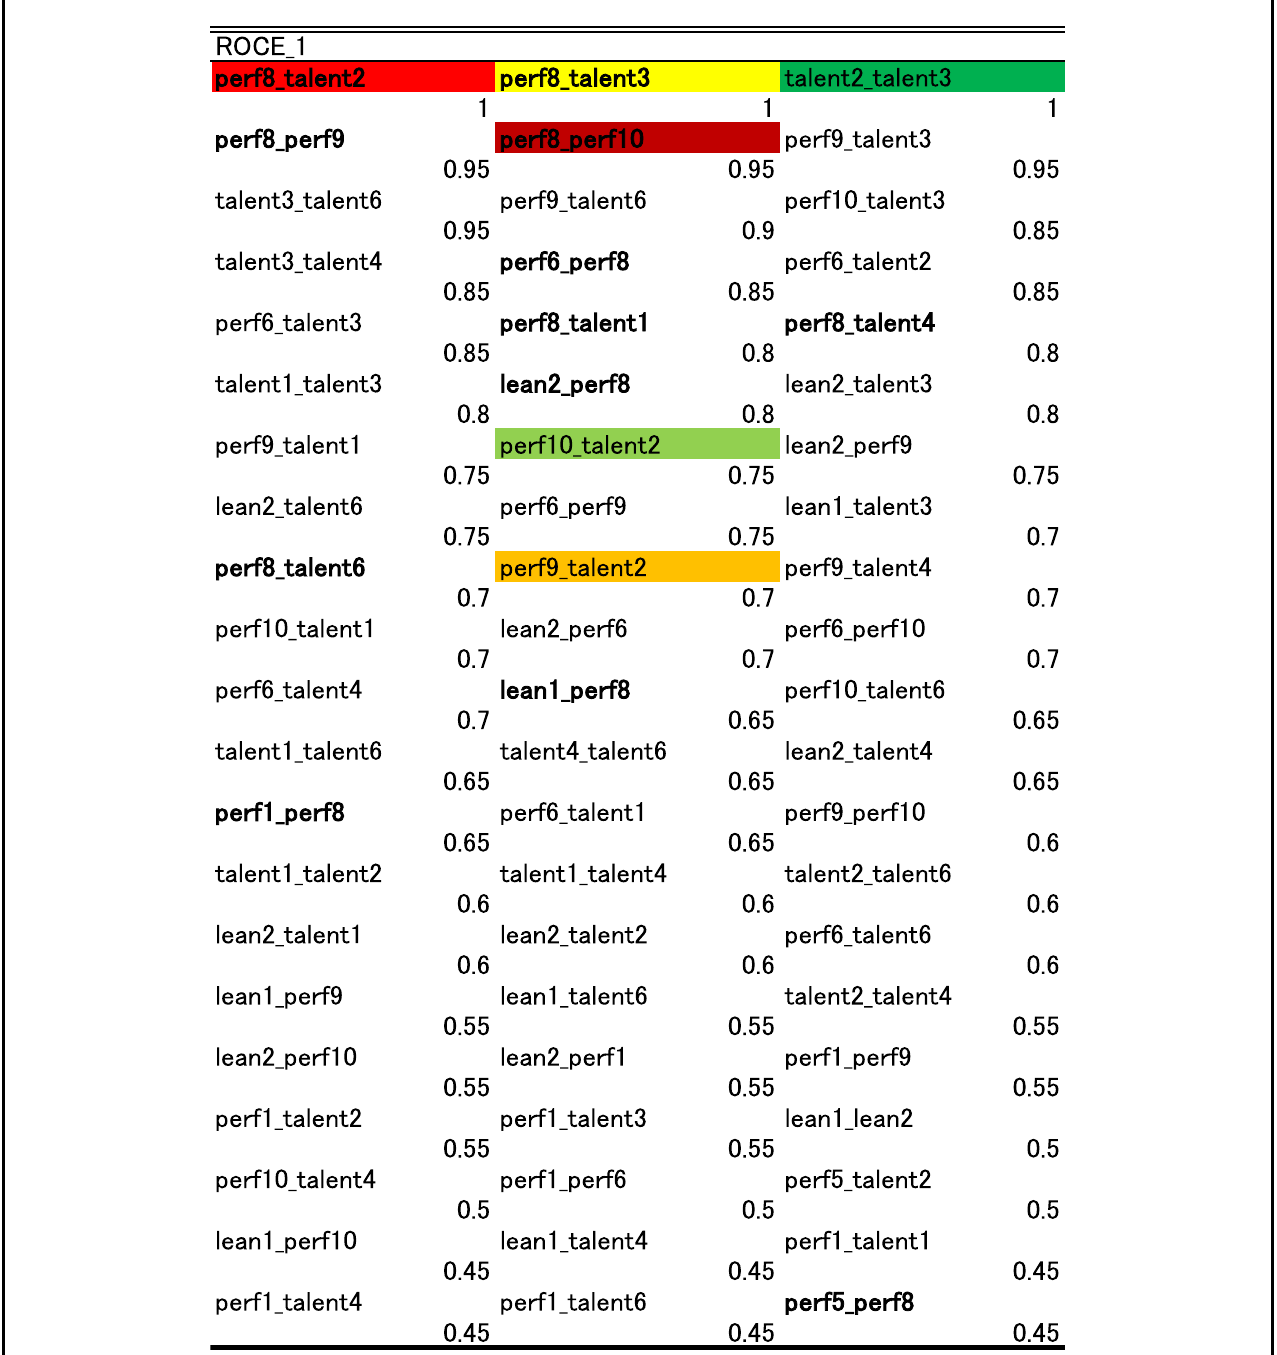
Table 4 a. Results of the iRF Analysis (top to bottom, in order of highest stability combination). b. Results of the iRF Analysis (top to bottom, in order of highest stability combination). c. Results of the iRF Analysis (top to bottom, in order of highest stability